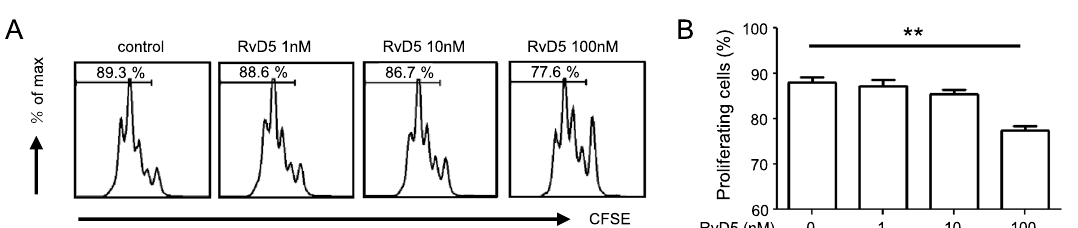
Figure 3. RvD5 suppresses CD4 + T cell proliferation. ( A ) CD4 + T cell proliferation measured by CFSE fluorescence. Data are representative of five independent experiments. ( B ) Frequencies of proliferating T cells in each group, analyzed by flow cytometry. Bars represent mean ± SEM. ** P < 0.01, * P < 0.05, by one-way analysis of variance and Tukey’s multiple comparison